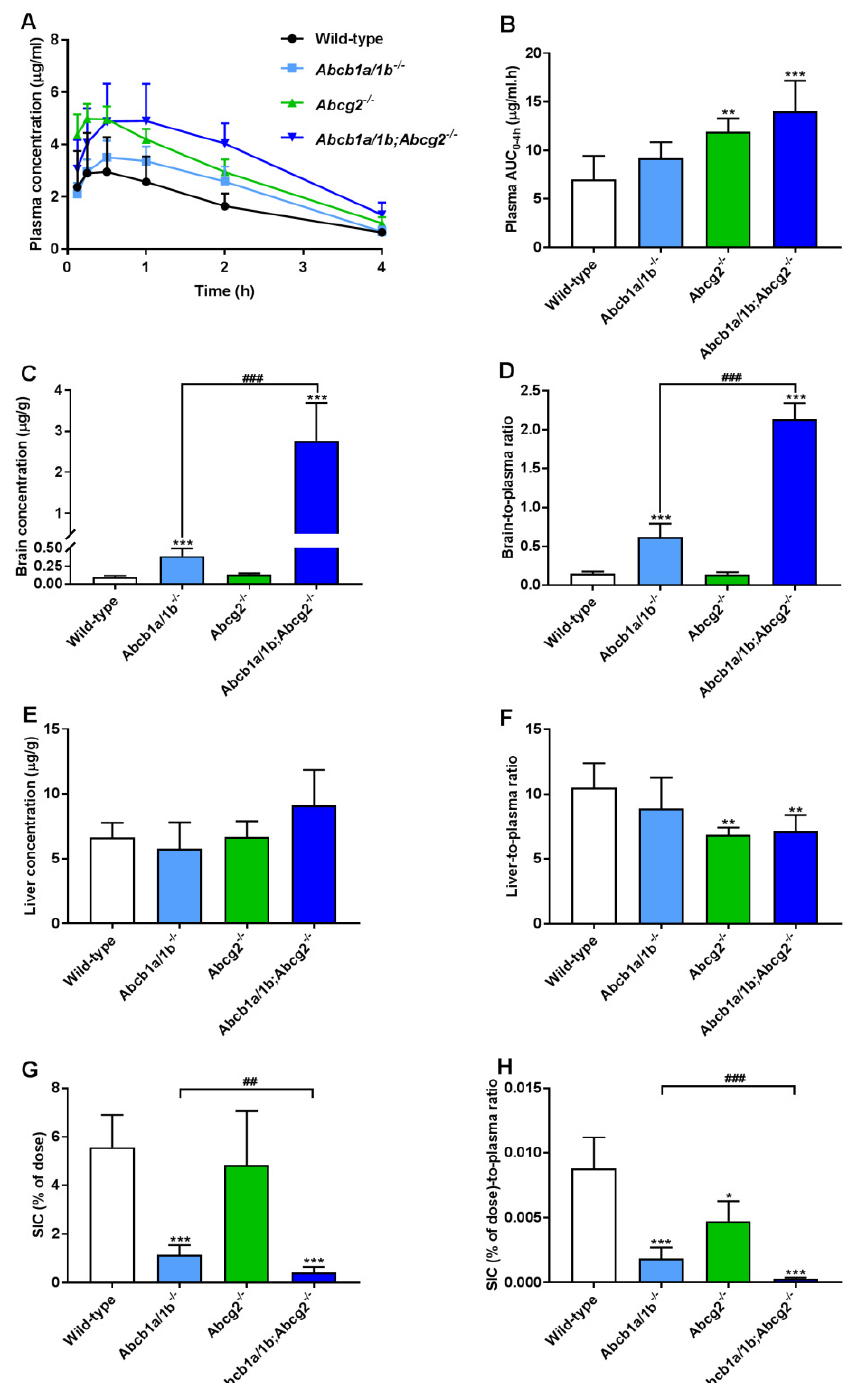
Figure 3. Plasma concentration-time curves ( A ), plasma AUC 0–4h ( B ), brain and liver concentration ( C , E ), small intestinal content (SIC) as percentage of dose ( G ), and brain-, liver-, SIC (% of dose)-to-plasma ratios ( D , F , H ) of repotrectinib in male wild-type, Abcb1a/1b − / − , Abcg2 − / − , and Abcb1a/1b;Abcg2 − / − mice 4 h after oral administration of 10 mg/kg repotrectinib. Due to inhomogeneous variance, brain and SIC data were first log-transformed before applying statistical analysis. SIC (% of dose), drug percentage of dose in small intestinal content expressed as total repotrectinib in SIC divided by total drug administered to the mouse. Data are presented as mean ± S.D. (n = 6–7). *, P < 0.05; **, P < 0.01; ***, P < 0.001 compared to wild-type mice. # , P < 0.05; ## , P < 0.01; ### , P < 0.001 comparing Abcb1a/1b;Abcg2 − / − mice to Abcb1a/1b − / − mice.